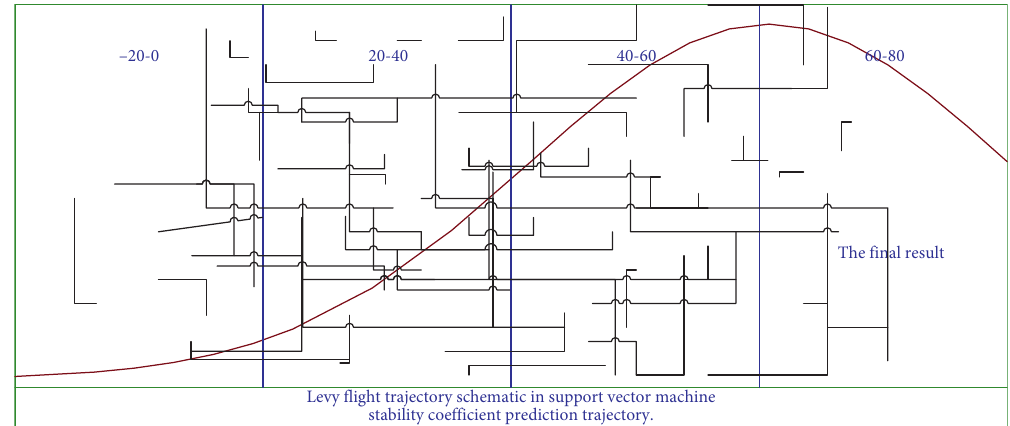
Figure 6: Levy flight trajectory schematic in SVM stability coefficient prediction trajectory.